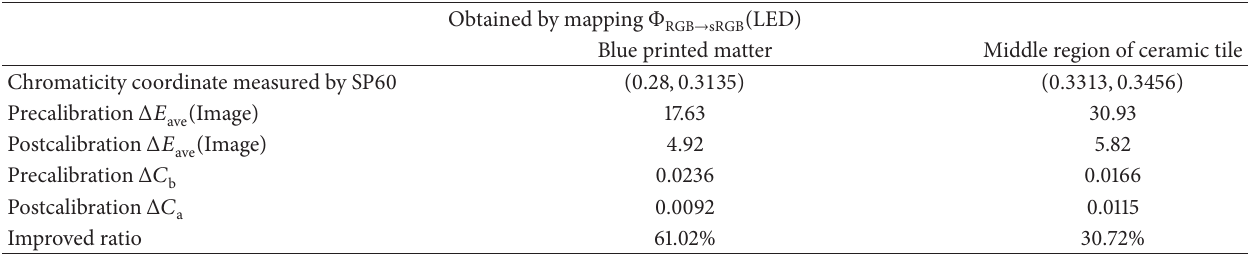
Table 5: The comparison of Δ𝐸 ave (Image), Δ C between captured images and reference value measured by SP60 before and after calibration. Obtained by mapping Φ RGB → sRGB (LED) Blue printed matter Middle region of ceramic tile Chromaticity coordinate measured by SP60 Precalibration Δ𝐸 ave